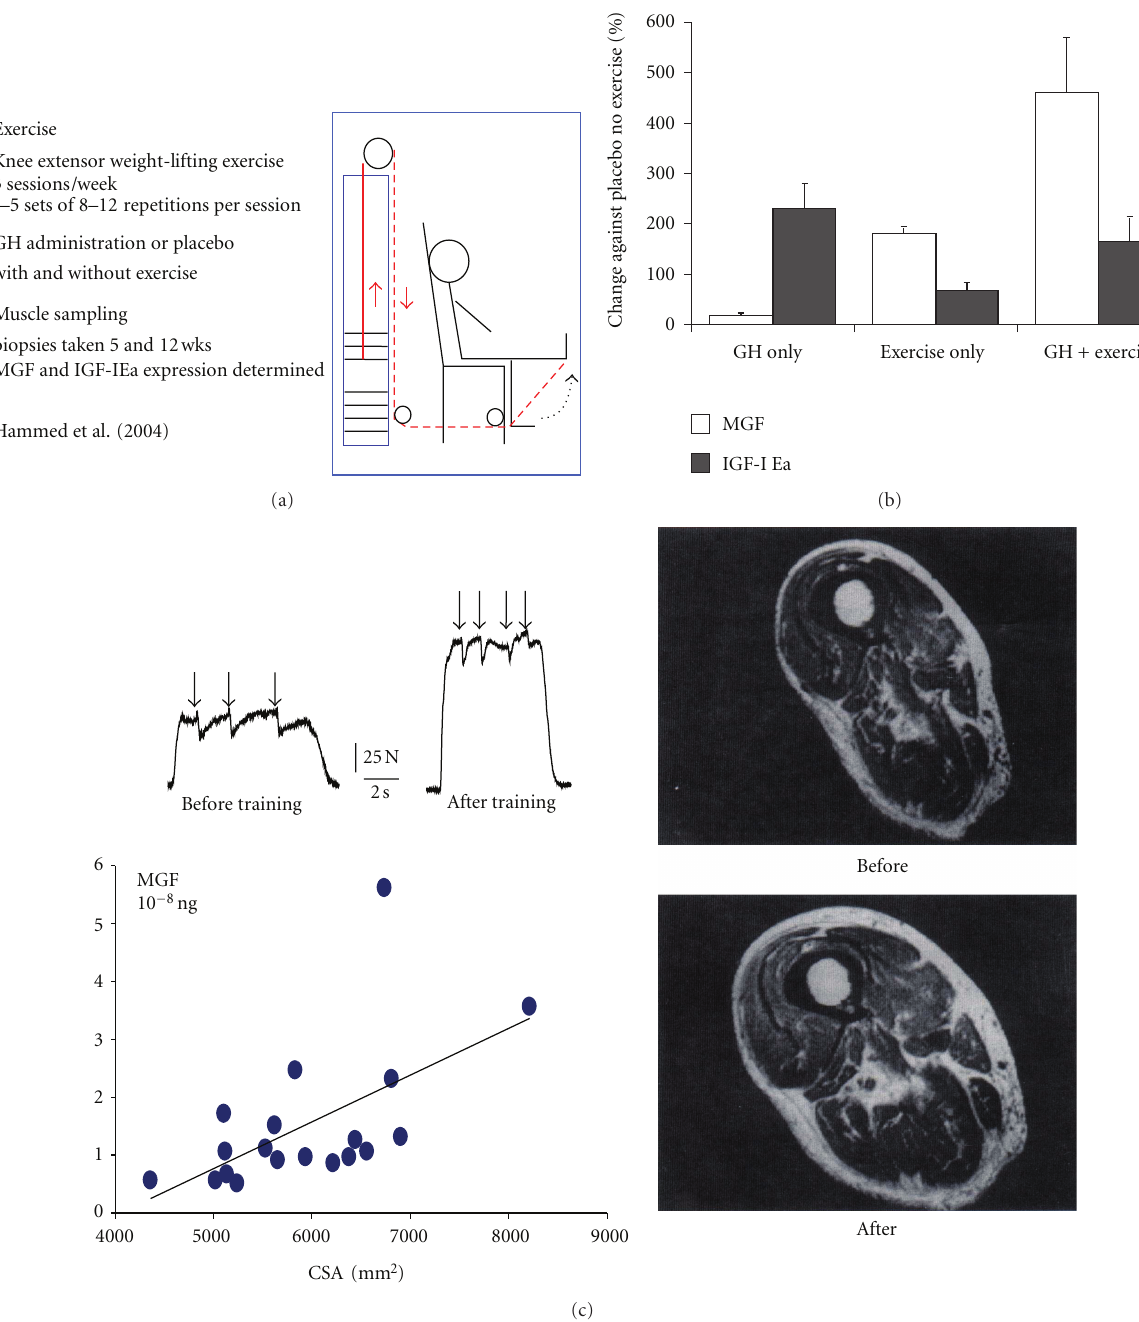
Figure 3: (a) Exercise data in which muscle MGF levels were determined in elderly men; some receiving exercise only and another group exercise with GH and in which biopsies were taken and MGF levels were measured and compared with muscle cross-sectional area and strength. (b) shows the relationship between the induced levels of MGF and the increased strength in the experiments presented in (a). (c) presents on the left side the change in muscle cross-sectional area after exercise combined with GH treatment and increased MGF expression in elderly men. On the right are two scans showing the di ff erence when exercise is combined (top right) or not combined with GH treatment (bottom left). See Hameed et al.